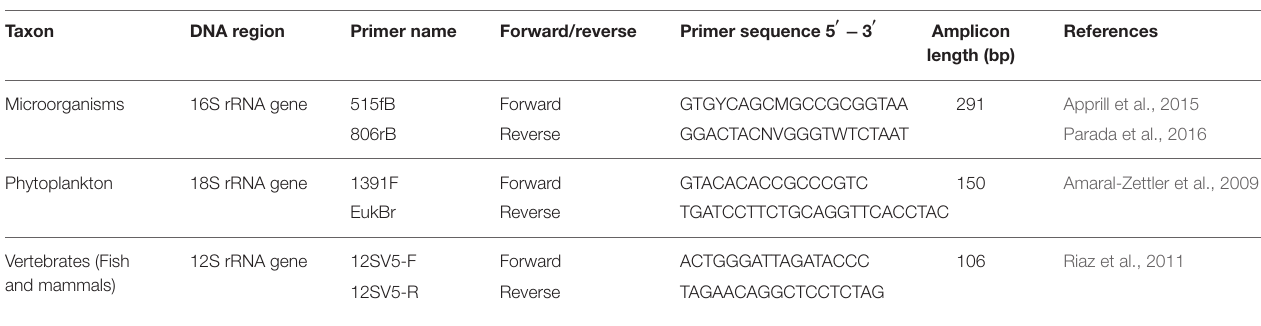
TABLE 1 | List of primers used in this study. Taxon